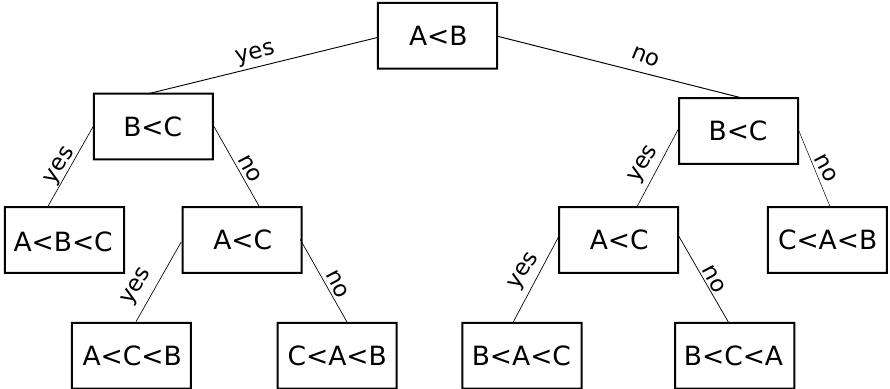
Figure 6. A simple DT for sorting the numbers A, B and C, assuming no two are equal. Since the DT is well defined, every leaf corresponds to possible sorting